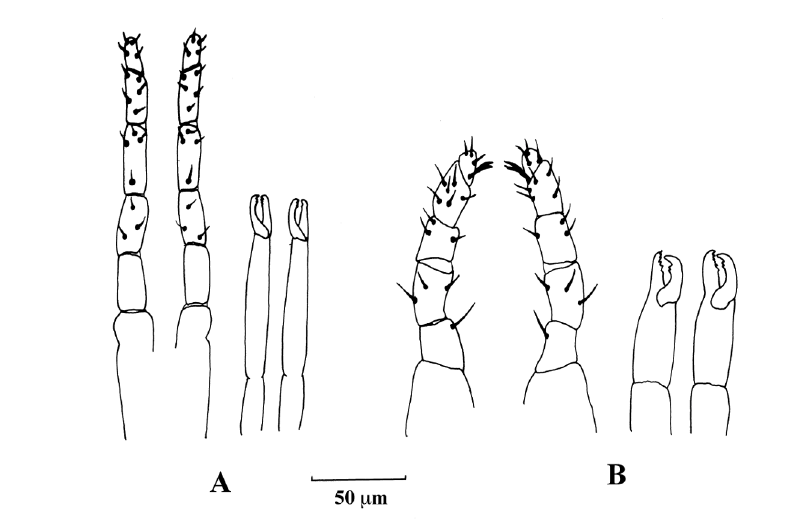
Fig. 6. Chelicera and pedipalps of Paragigagnathus tamaricis (Amitai and Grinberg) (A) and Cydno- dromus californicus (McGregor) (B) (original